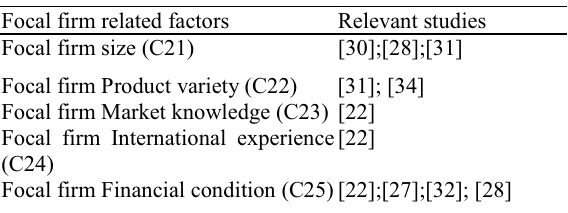
Table 2: Focal firm related